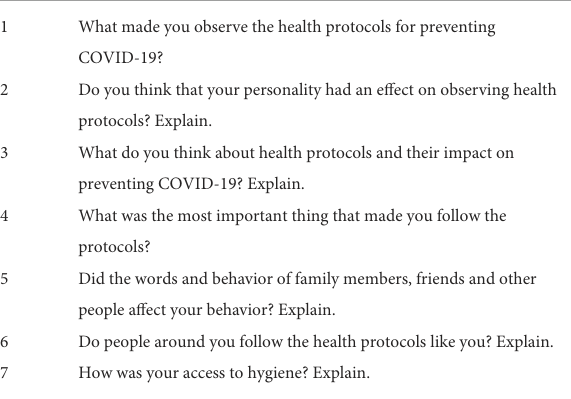
TABLE 1 The guide for interview